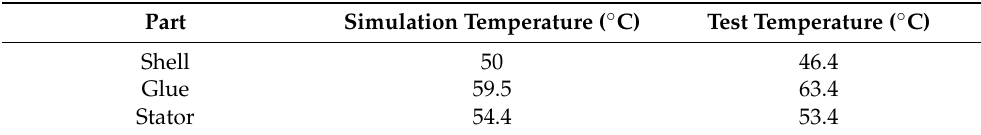
Figure 19. Test temperature. Table 4. Comparison of simulated and measured